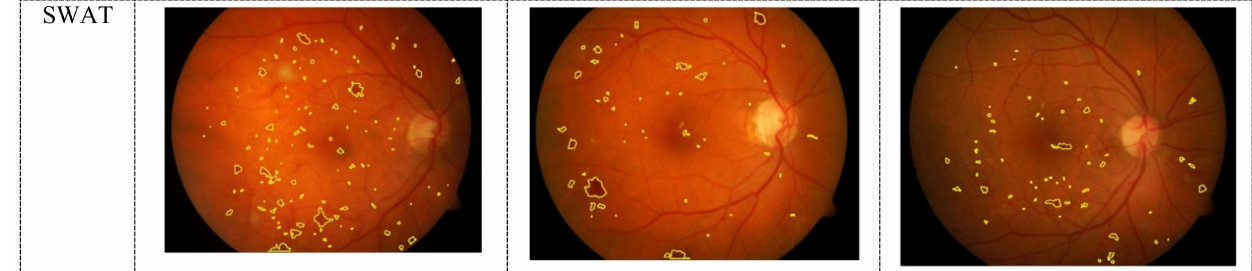
Figure 7. Results of the different segmentation methods on the DIARETDB0 dataset.